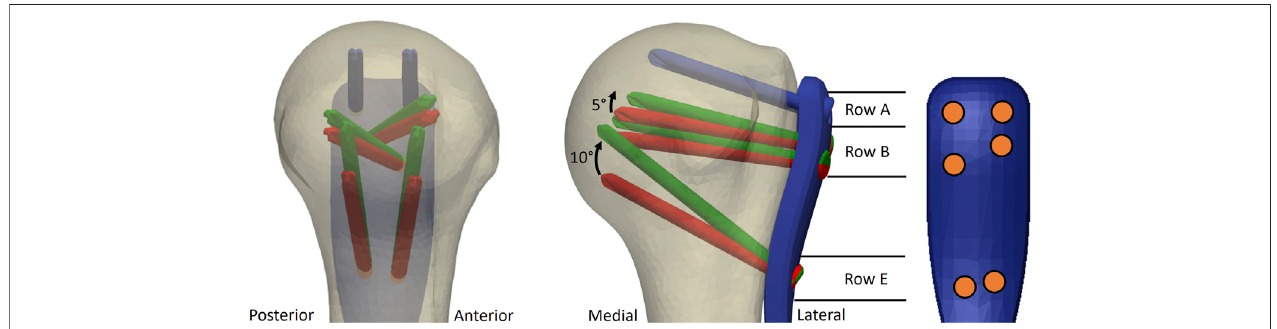
FIGURE2| Illustrationoftheoriginal(OG,red)andtheenhanced(EH,green)screwtrajectoriesusedfortheexperimentalvalidationstudy.Themostproximalscrew row (blue) was the same for both OG and EH designs. Screws of row E were rotated proximally by 10 ° and screws of row B by 5 ° , respectively, compared to the OG con fi guration. Note that the intact bone is used only for illustration; the fi xation was optimized in virtual fracture models. The screw distribution on the plate is illustrated with orange circles.